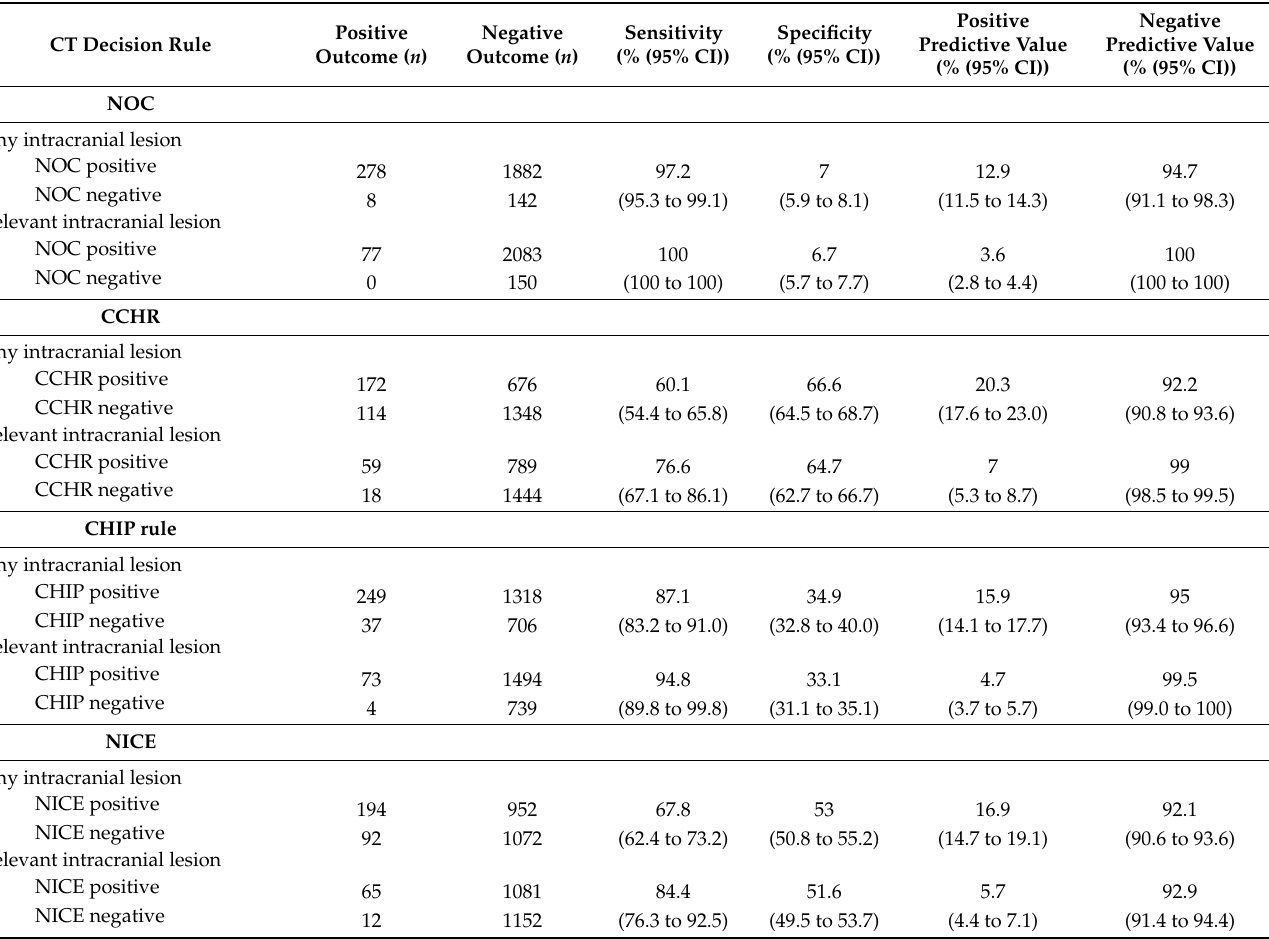
Table 3. Performance of the four commonly used decision rules in 2310 elderly patients with MHI when age was excluded as a risk factor.